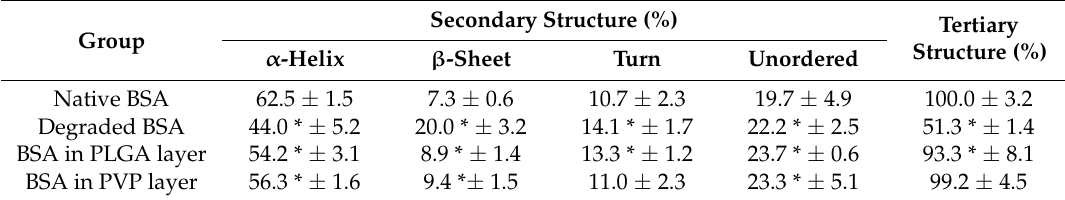
Table 1. Structural stability of BSA in PLGA and PVP layers. The distributions of secondary structure were estimated from circular dichroism (CD) spectra, and the changes in the tertiary structure were estimated by comparing the peak fluorescence intensity of samples with that of native BSA at 339 nm.